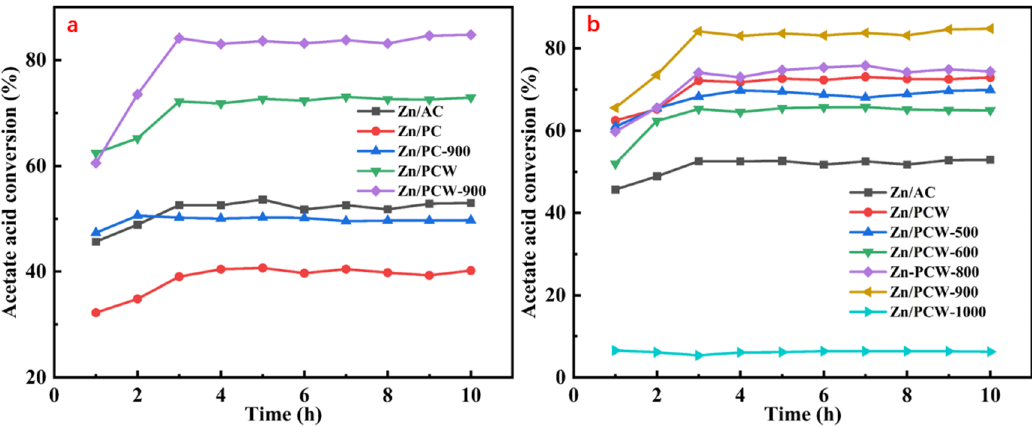
Figure 1. Conversion of acetic acid of Vinyl acetate with Zn/PC, Zn/AC, Zn/PCW, and Zn/PCW ‐ 900 ( a ) and conversion of acetic acid with Zn/PCW at different calcination temperatures ( b ).